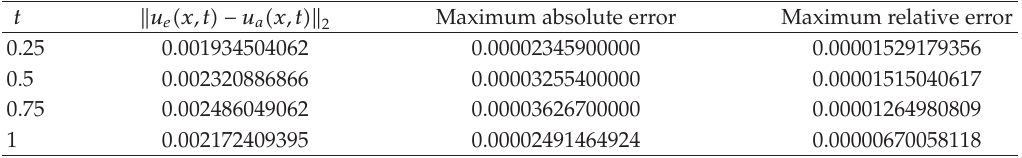
Table 2: L 2 -norm error (cid:7) u e (cid:3) x,t (cid:4) − u a (cid:3) x,t (cid:4) (cid:7) times t (cid:9) 0.25, 0.50, 0.75, and